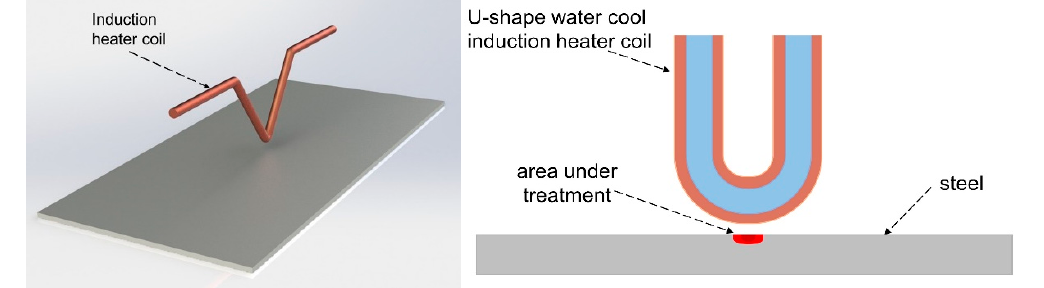
Figure 5. The V-shaped or U-shaped conductor is providing the local magnetic flux density inducing eddy currents for localized heat treatment, used for the results of Figure 4d.